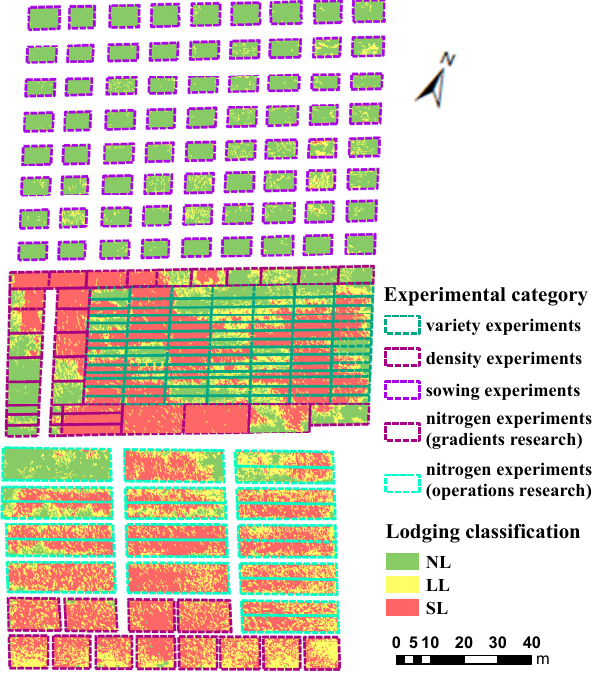
Figure 15. Distribution of maize with different degrees of lodging. We applied a regional statistical analysis to the map of Figure 15 combined with the map of the maize variety to calculate the fraction of each maize variety that undergoes some degree of lodging. The top three varieties most resistant to lodging were Liao- dan585, LP68, and Zhongdan909 (Figure 16). Figure 17 maps the top 20 varieties in terms of lodging resistance. Most of the maize varieties with zero lodging were located on the edge of the field, although a few were distributed in the center, such as Fuer5152 and Zhengyuenyu432, which indicates that these maize varieties offer superior resistance to lodging.